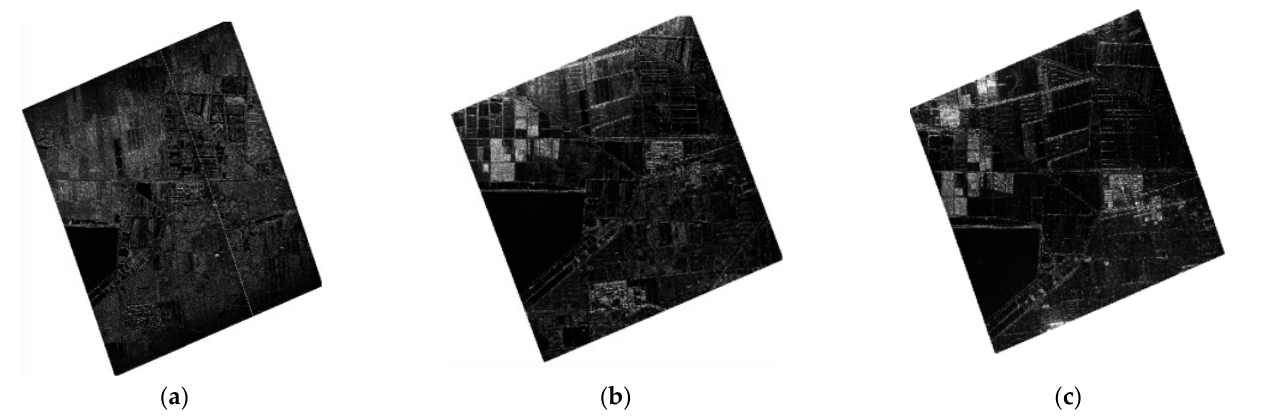
Figure 6. Image mosaicking. ( a ) L-band SAR images. ( b ) P-band SAR images. ( c ) C-band SAR images.